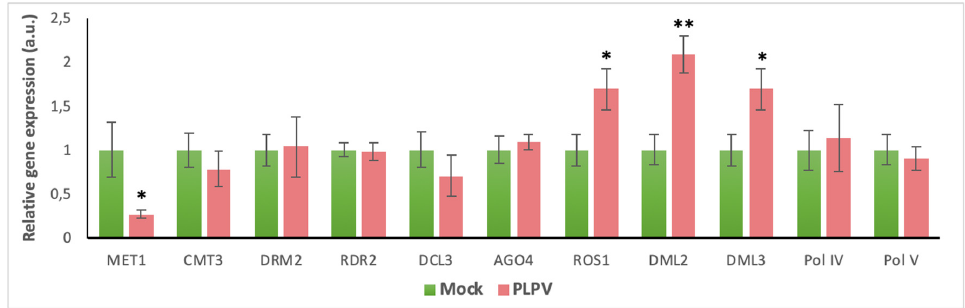
Figure 2. Expression levels of DNA methylation / demethylation genes during a PLPV infection. RT-qPCR analysis of mRNA levels of the selected genes in systemic leaves from mock-inoculated (green) and PLPV-infected plants (red) harvested at 34 d.p.i. Bars depict standard deviations from three independent biological replicates and the statistical significance was tested using a paired t -test (* p < 0.05; ** p < 0.01).